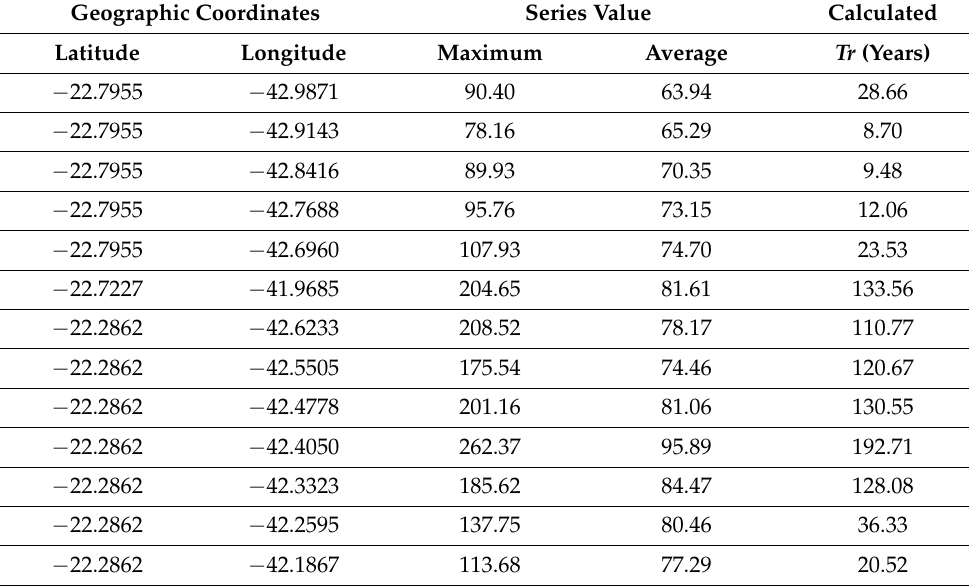
Table 2. Example points. Columns 1 and 2 are the geographic coordinates; column 3 is the maximum value of precipitation of the historical series; column 4 calculates the value of the average of the years of the historical series; and column 5 is the value of the return time that the precipitated volume (mm) represents. Geographic Coordinates Series Value Calculated Latitude Longitude Maximum Average Tr (Years) −